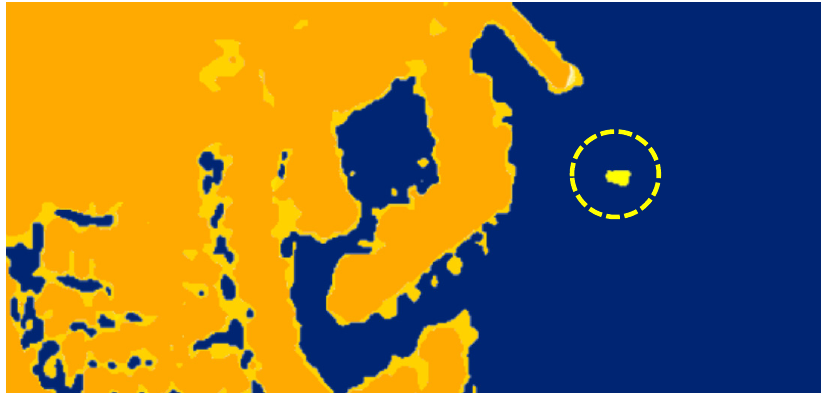
11 of 19 Figure 10. Left : results of the sensitivity analysis in bar graph for each of the nine indices. Right : Plastic Index (PI) scatterplot showing the discriminating value (DV) between water and plastic bottles. The plastic bottles values are circled in red.